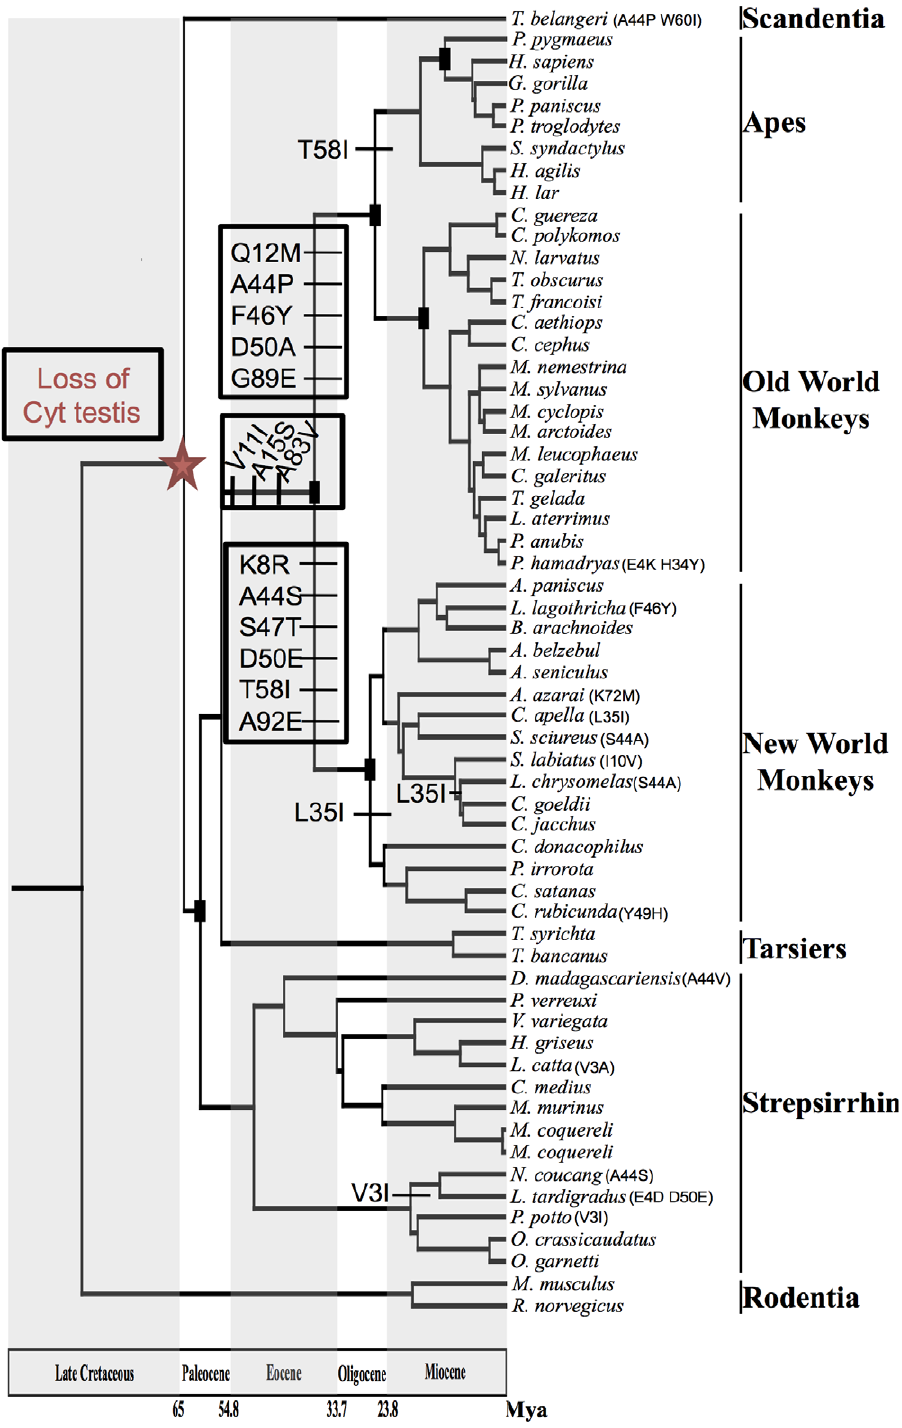
Figure 1. Phylogenetic relationships among primates estimated from cytochrome c sequence. The same phylogenetic tree was obtained using (separately) maximum likelihood, maximum parsimony and Bayesian approaches. Divergence times were estimated by the Bayesian local molecular clock approach. Only non-synonymous mutation events of internal branches are shown. doi:10.1371/journal.pone.0026269.g001 44 and 50, were replaced independently in both lineages. Unlike by the changes (Table S2): (i) The phosphorylation epitope residue 44, which is highly variable among the eukaryotes Tyr-48 (residues 41 to 55 ) [12]. Six amino acid replacements (Consurf score= 2.5; Table S2), residue 50 has a slow replacement were inferred to have occurred independently and in parallel on rate among the eukaryotes (Consurf score= 0.9; Table S2), but the platyrrhine and catarrhine lineages. Interestingly, two residues,